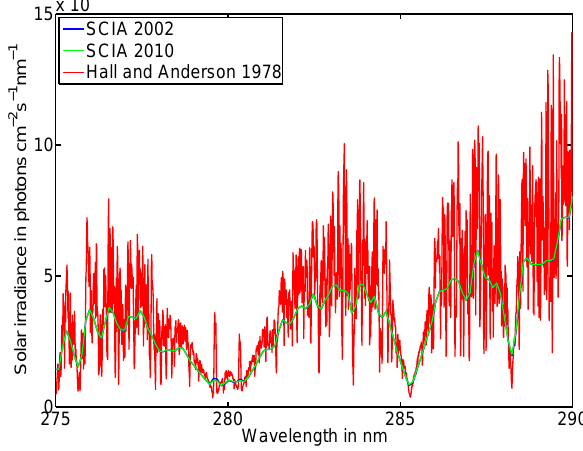
Fig. 9. High resolution solar spectrum from Hall and Anderson (1991) (data from 1978) in comparison to the SCIAMACHY solar irradiance spectrum during high solar activity (2002) and low so- lar activity (2010). There are especially strong differences between the high resolution spectrum and the SCIAMACHY spectrum in the Fraunhofer lines at 279.6, 280.4, 285.2 and 288.2nm. When smoothed and scaled, the high resolution spectrum is very similar to the SCIAMACHY spectrum (see Fig.